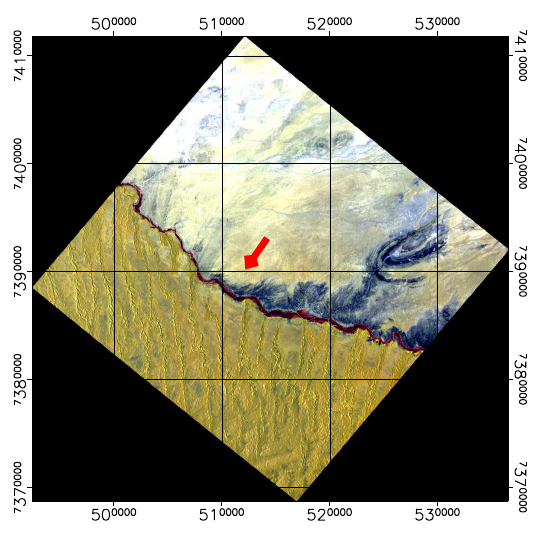
Figure 9. GONA, 4 February 2019, L2A CIR image, non-linear stretch; coordinates given in WGS-84, UTM Zone 33 S. Arrow pointing towards the RadCalNet location (red dot).